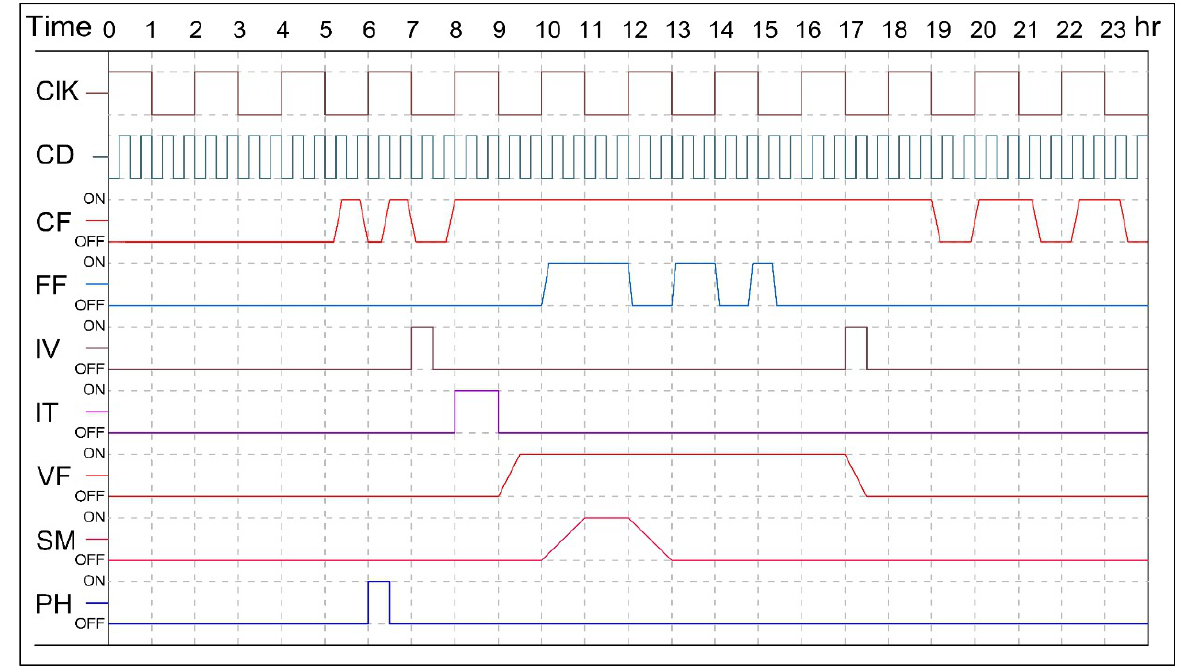
Figure 15. Timing diagram of ON/OFF operations of the greenhouse actuators. Clk: Clock for timing; CD: Collected Data; CF: Cooling Fan; FF:Fogger Fan; IV: Irrigation Valve controlled by the moisture sensors; IT: Irrigation valve controlled by the digital Timer; VF—Ventilation